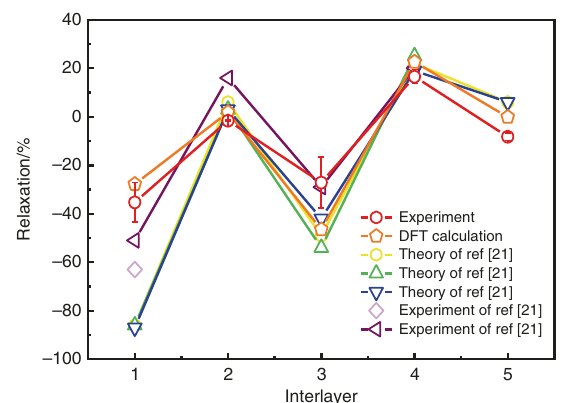
Fig. 4 Interlayer relaxation of α -Al 2 O 3 in percent of the corresponding bulk spacings. The relaxation from the fi rst layer (Al) to the second layer (O) is − (35.3 ± 8.2)%. The DFT calculation and previous results are also plotted for comparison. The error bar of experimental relaxation is calculated from the SD of bond